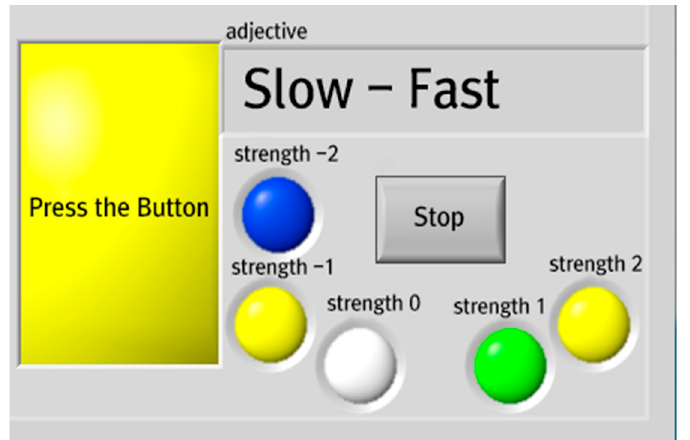
Figure 2. Experimental environment.